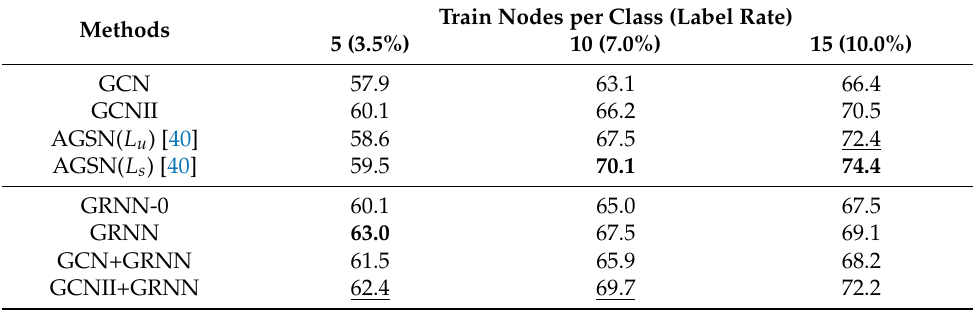
Table 7. Summary of classification accuracy (%) results on Wiki. Methods